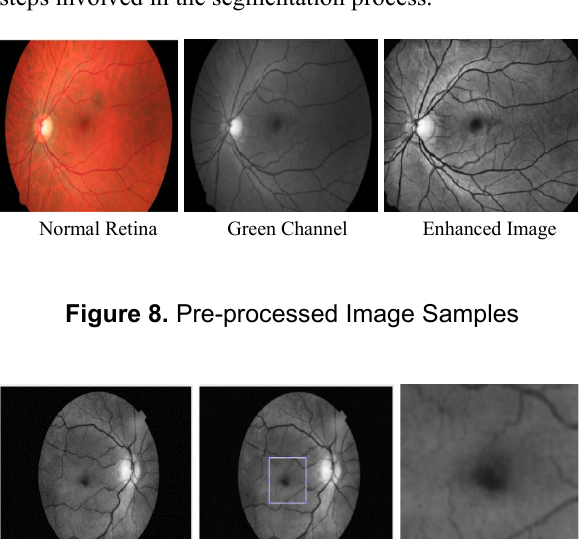
Figure 9. Segmentation Process